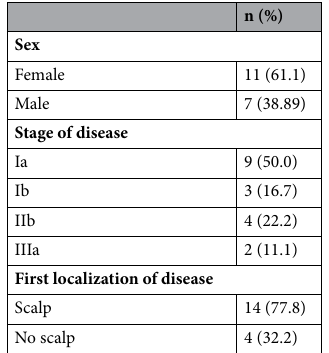
Table 1. Data about gender, stage of disease and first localization of disease in our study